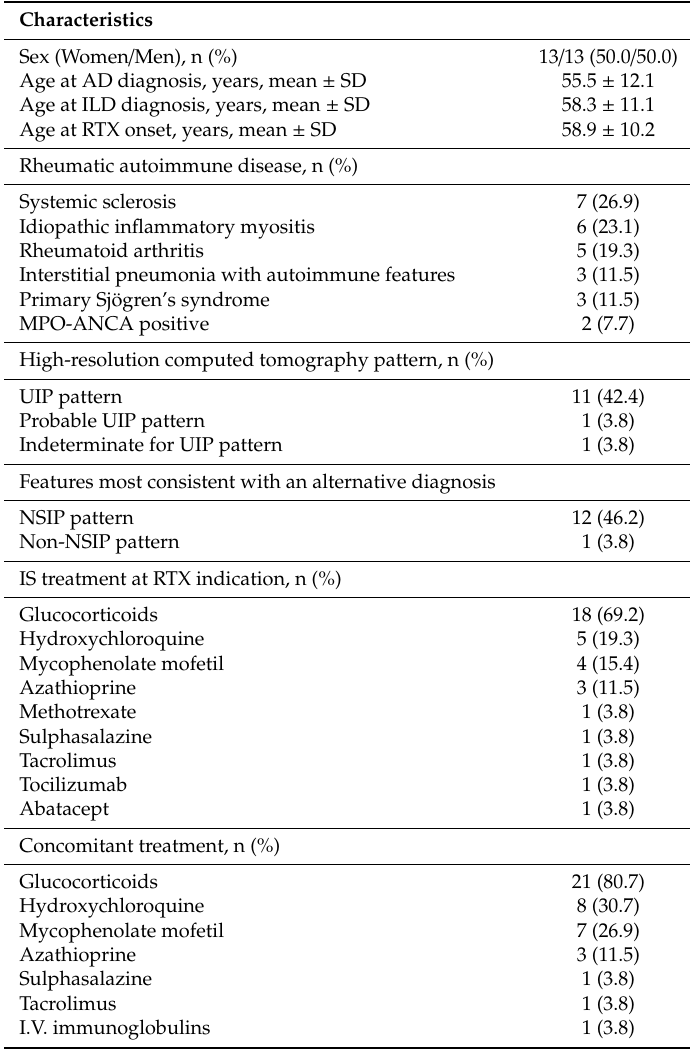
Table 1. Demographic and clinical characteristics of 26 AD-ILD patients included in this